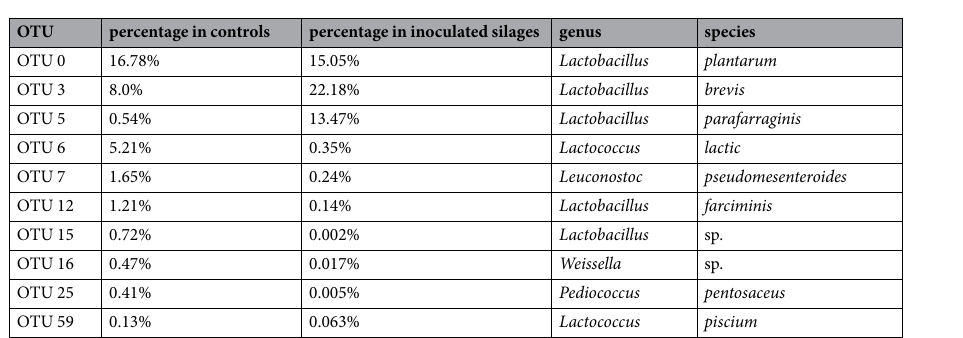
Figure 3. Taxonomic profiles of ensiling microbial communities on the taxonomic ranks of phylum. Profiles shown here are based on 16S rDNA amplicon sequences and were classified applying the RDP Classifier after quality filtering of the dataset. Silage samples are labelled with Arabic numerals indicating the day of ensiling. Controls represent the naturally fermented silages. Inoculated silages represent silages with the addition of Lb . brevis SDMCC050297 and Lb . parafarraginis SDMCC050300.